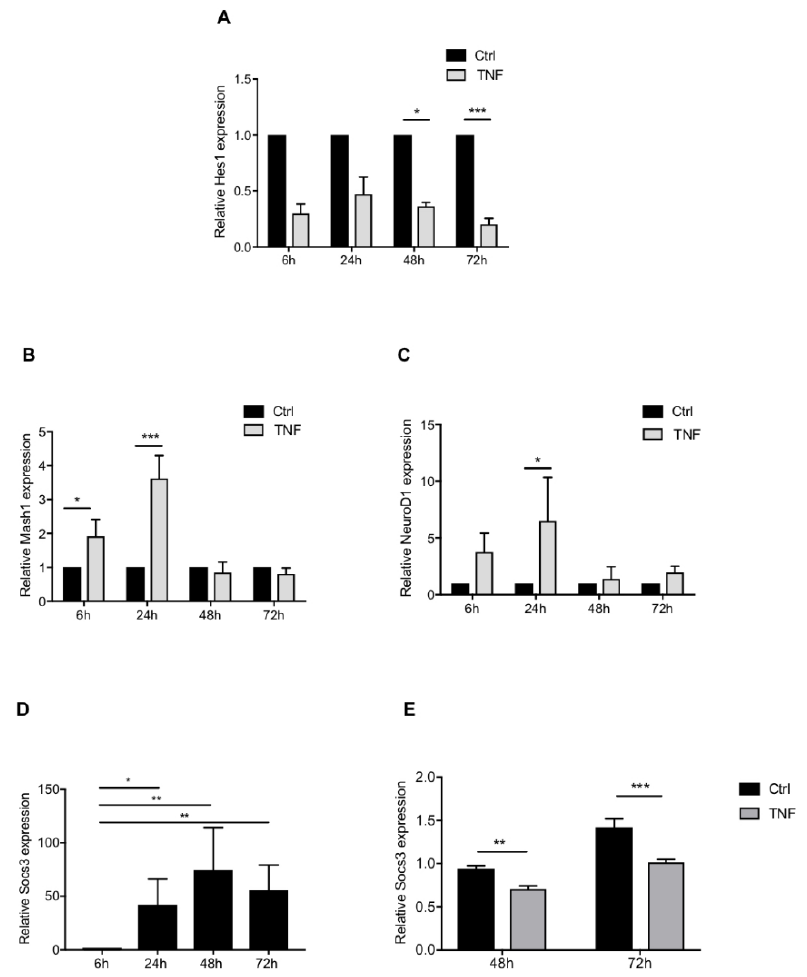
Figure 6. Effect of NF-kB activation on the main astrocytic signaling pathways during NSPs differ- entiation into astrocytes. Effect of TNF treatment on Hes1 ( A ), Mash1 ( B ), and NeuroD1 ( C ) genes expression obtained by RT-PCR. Each time point is normalized to its FBS control (Ctrl = 1). Results are given as mean ± SEM ( n = 4). Kinetic of Socs3 mRNA gene expression obtained by RT-PCR. Each time point is normalized to 6 h of differentiation. Results are given as mean ± SEM ( n = 3) ( D ). Effect of TNF treatment on Socs3 gene expression obtained by RT-PCR. Results are given as mean ± SEM ( n = 6) ( E ). * p < 0.05, ** p < 0.01 and *** p <